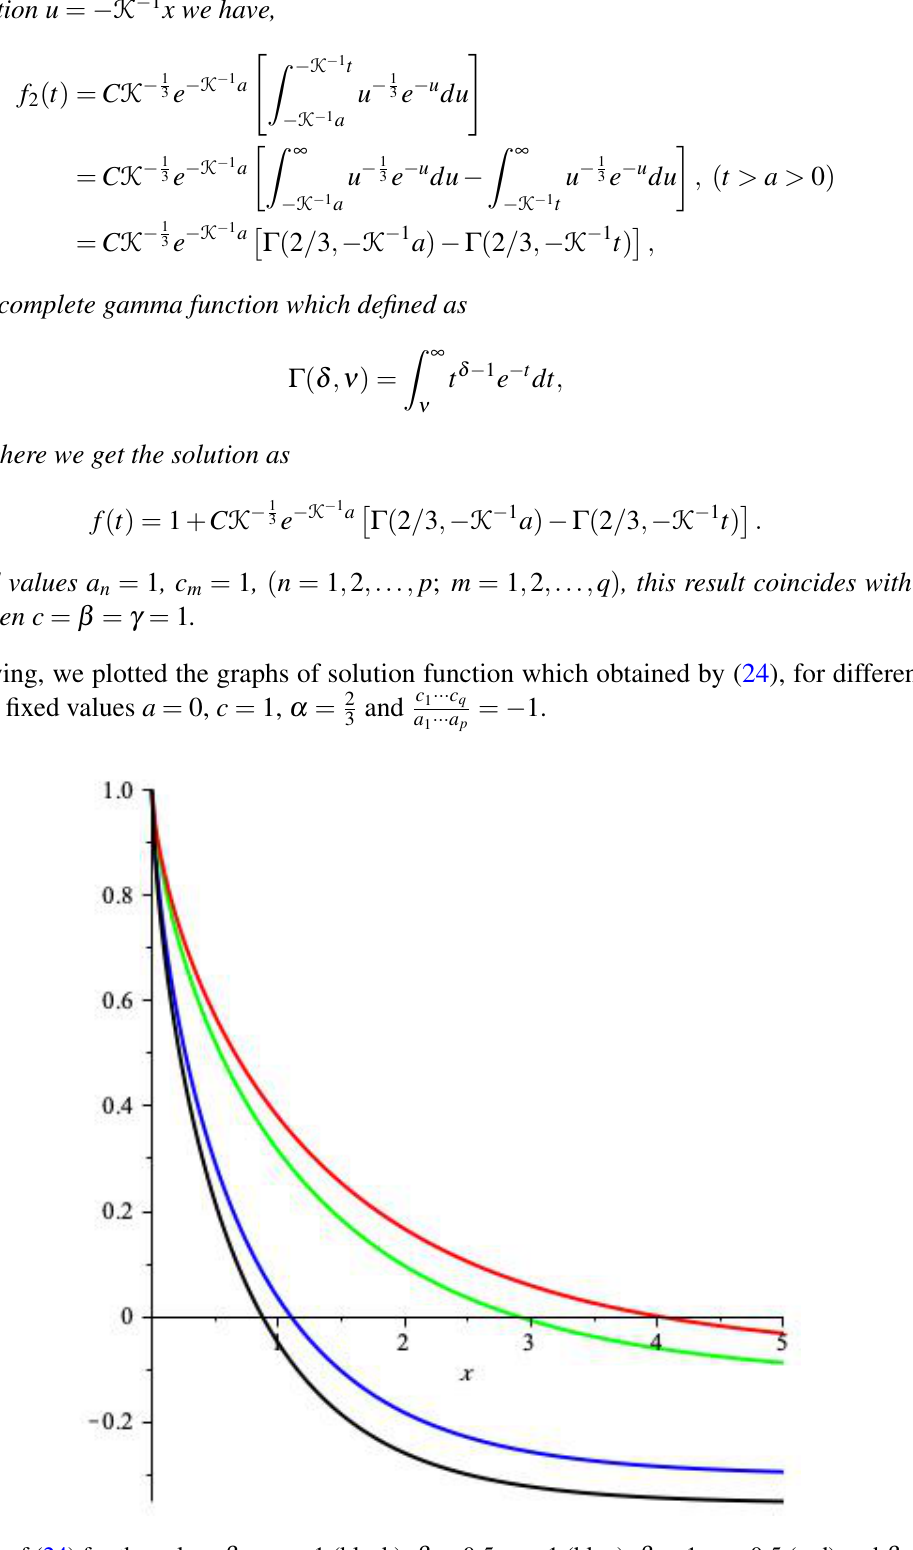
Fig. 3 The graphs of (24) for the values β = γ = 1 (black); β = 0 . 5 , γ = 1 (blue); β = 1 , γ = 0 . 5 (red) and β = γ = 0 . 5